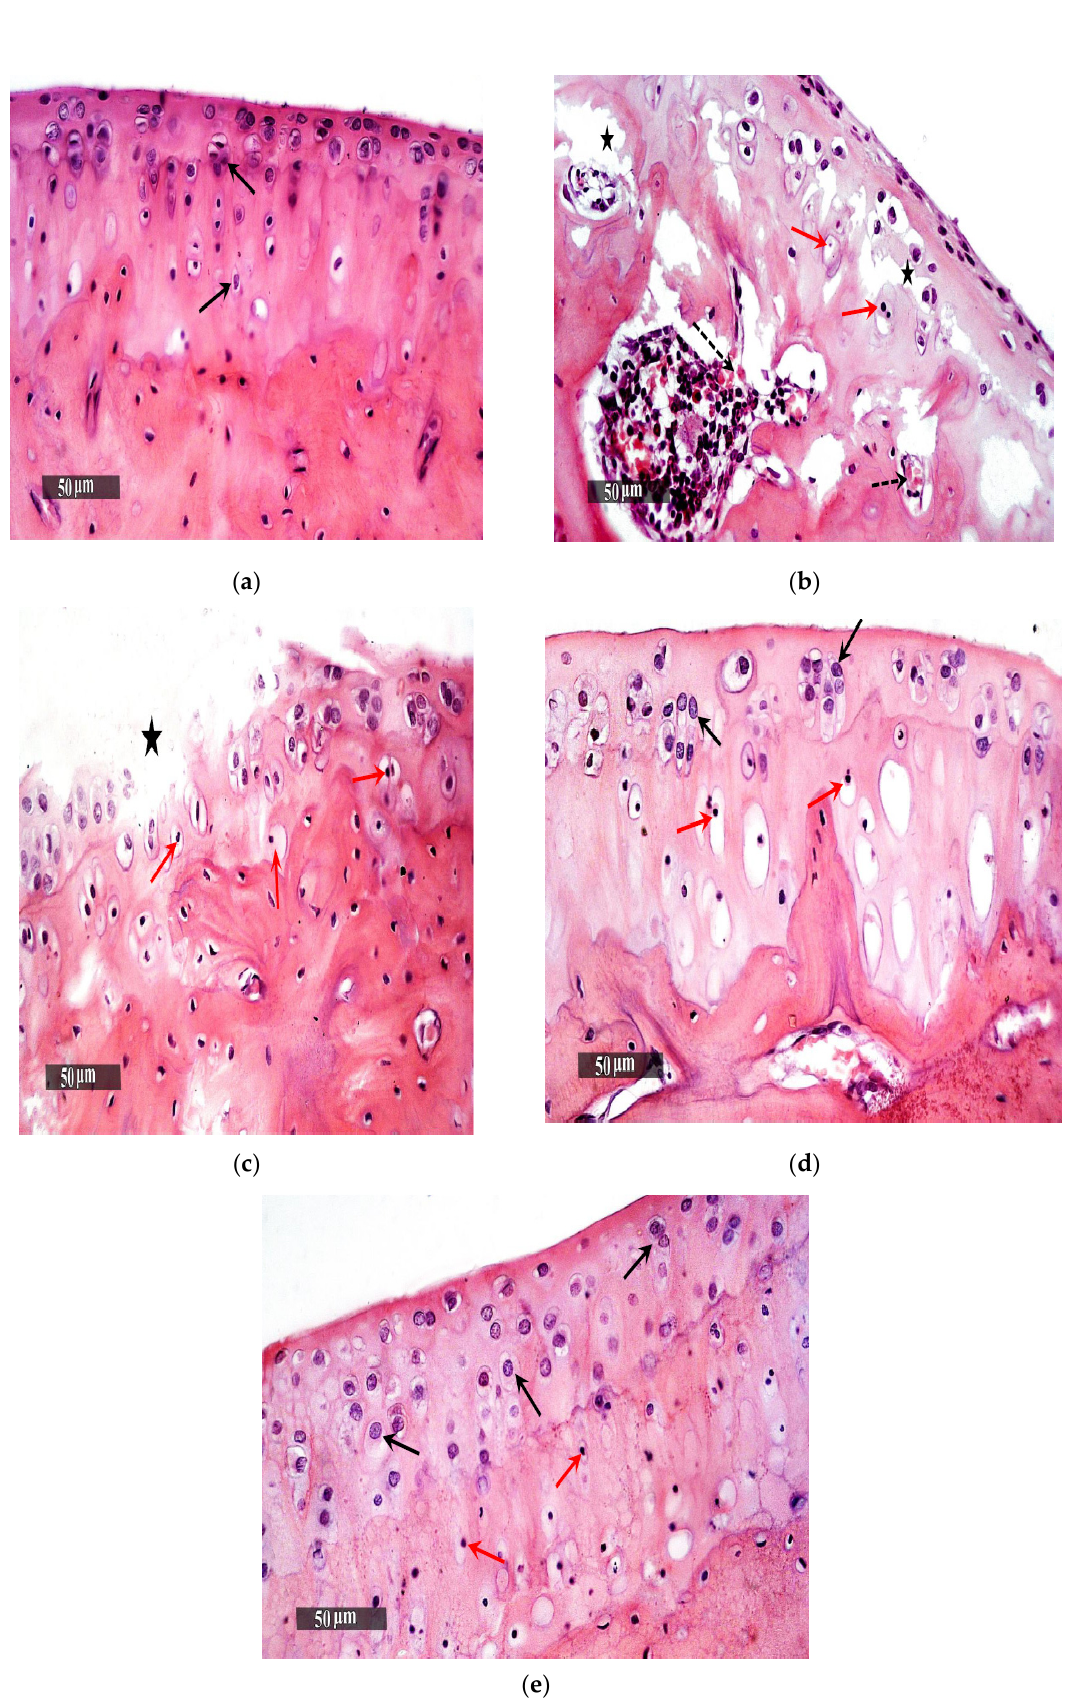
Figure 7. Morphological assessment of articular cartilage of different study groups: GP1 (negative control), GP2 (positive control), GP3 (Blank hyaluosome), GP4 (DCN aqueous dispersion), and